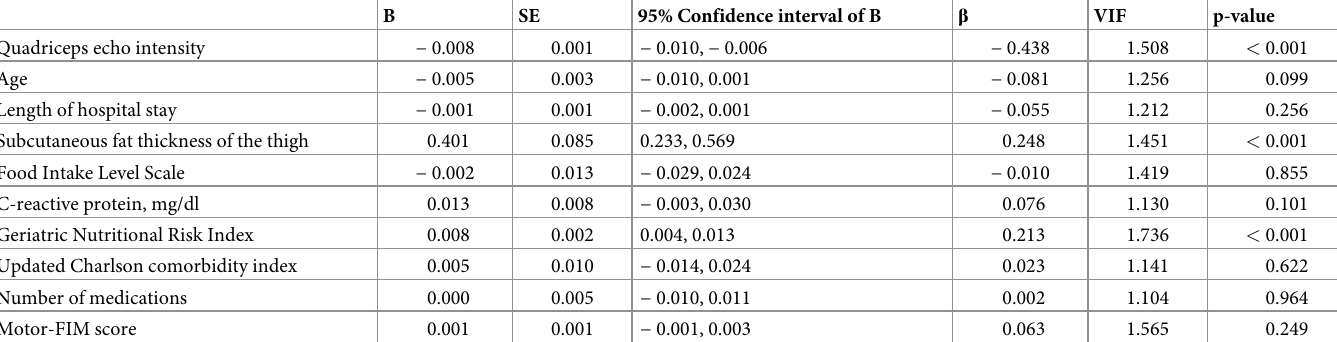
Table 3. Multiple regression analysis for muscle thickness in female model with forced entry method (n =